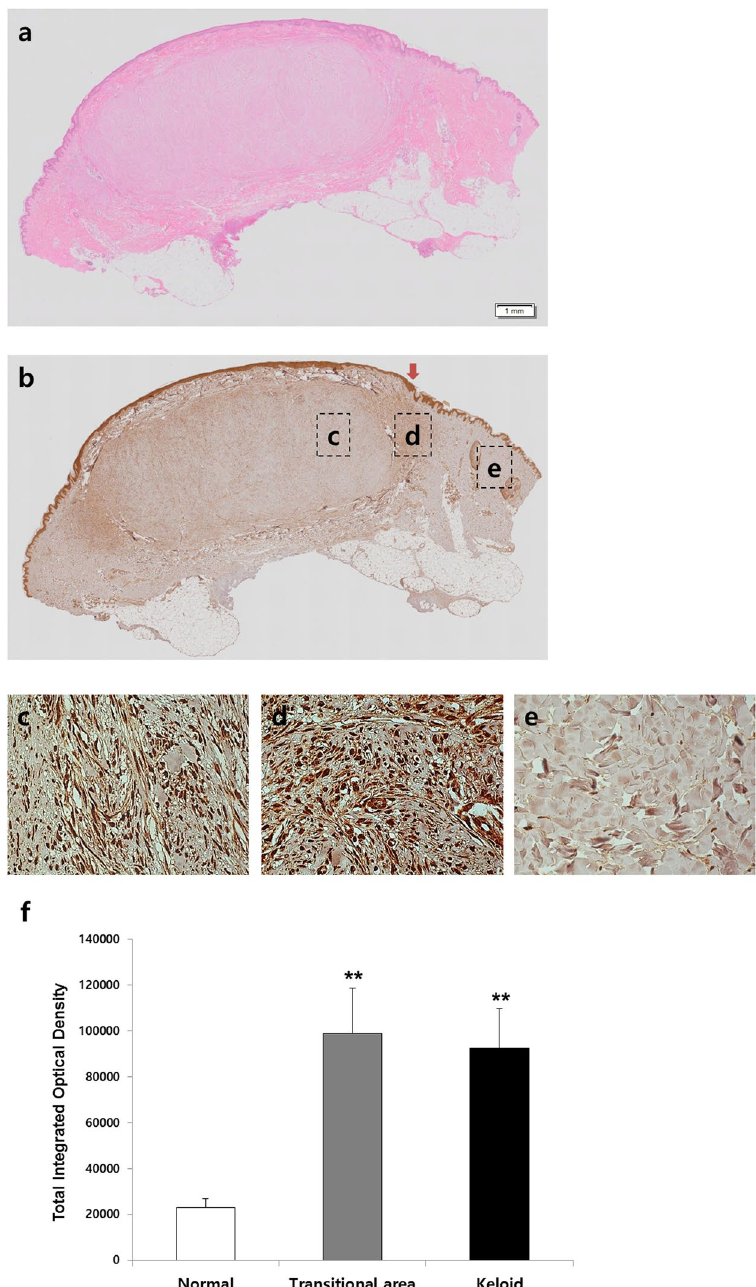
Figure 1. Immunohistochemical staining of mortalin in human keloid tissues. ( a ) Keloid tissue had a dense and excessive collagen deposition that extended over the clinical keloid margin into the extra-lesional dermal tissue. The expression of mortalin in keloid tissue ( b & d ) was increased than that in adjacent normal tissue (e), especially peripheral keloid region ( d ). ( f ) On the semi-quantitative Metamorph ® image analysis, the expression of mortalin increased by 4.8 times than adjacent normal tissue, and this difference was statistically significant ( ** p <